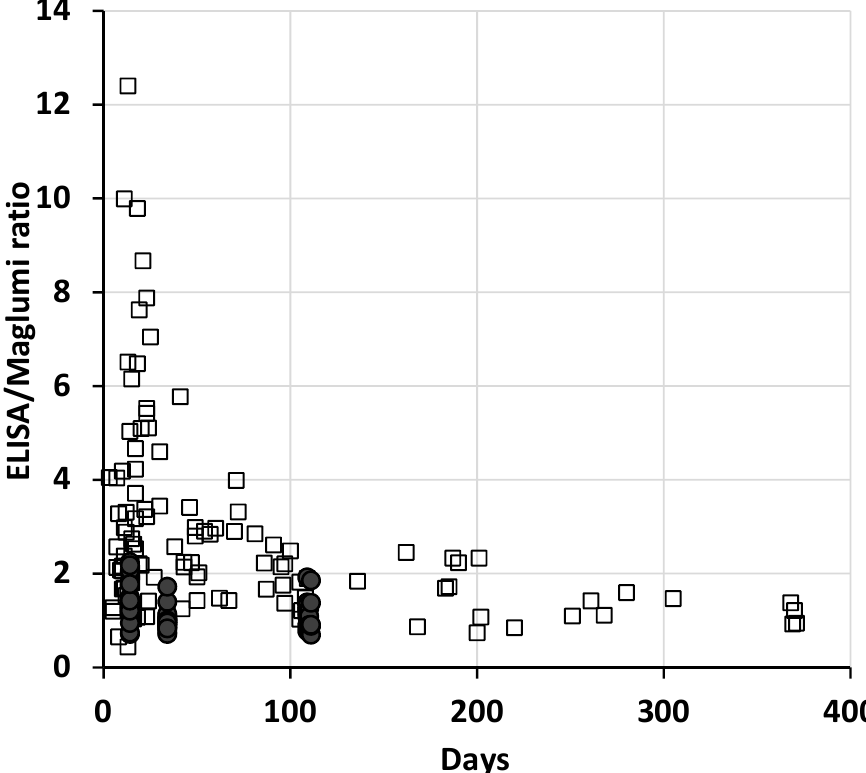
Figure 1. Plot of the ratios of each specimen between ELISA and Maglumi vs. the days from the onset of symptoms, or from the first inoculum of vaccine. The open squares represent the patient specimens and the filled circles the vaccinated subjects.